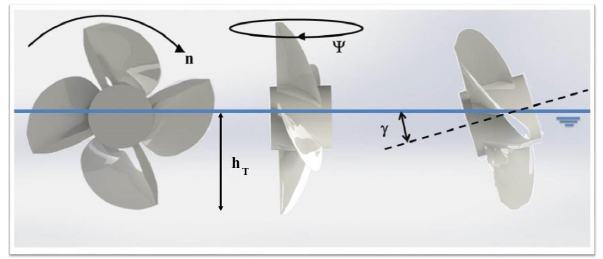
Figure 1. Different propeller location